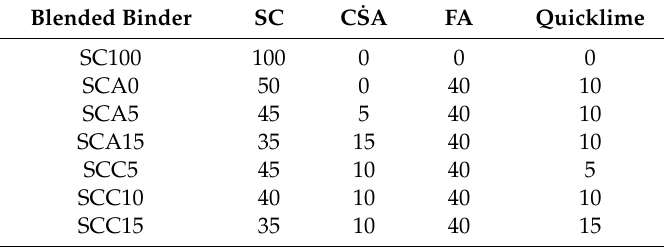
Table 2. Mixing ratios of blended binders